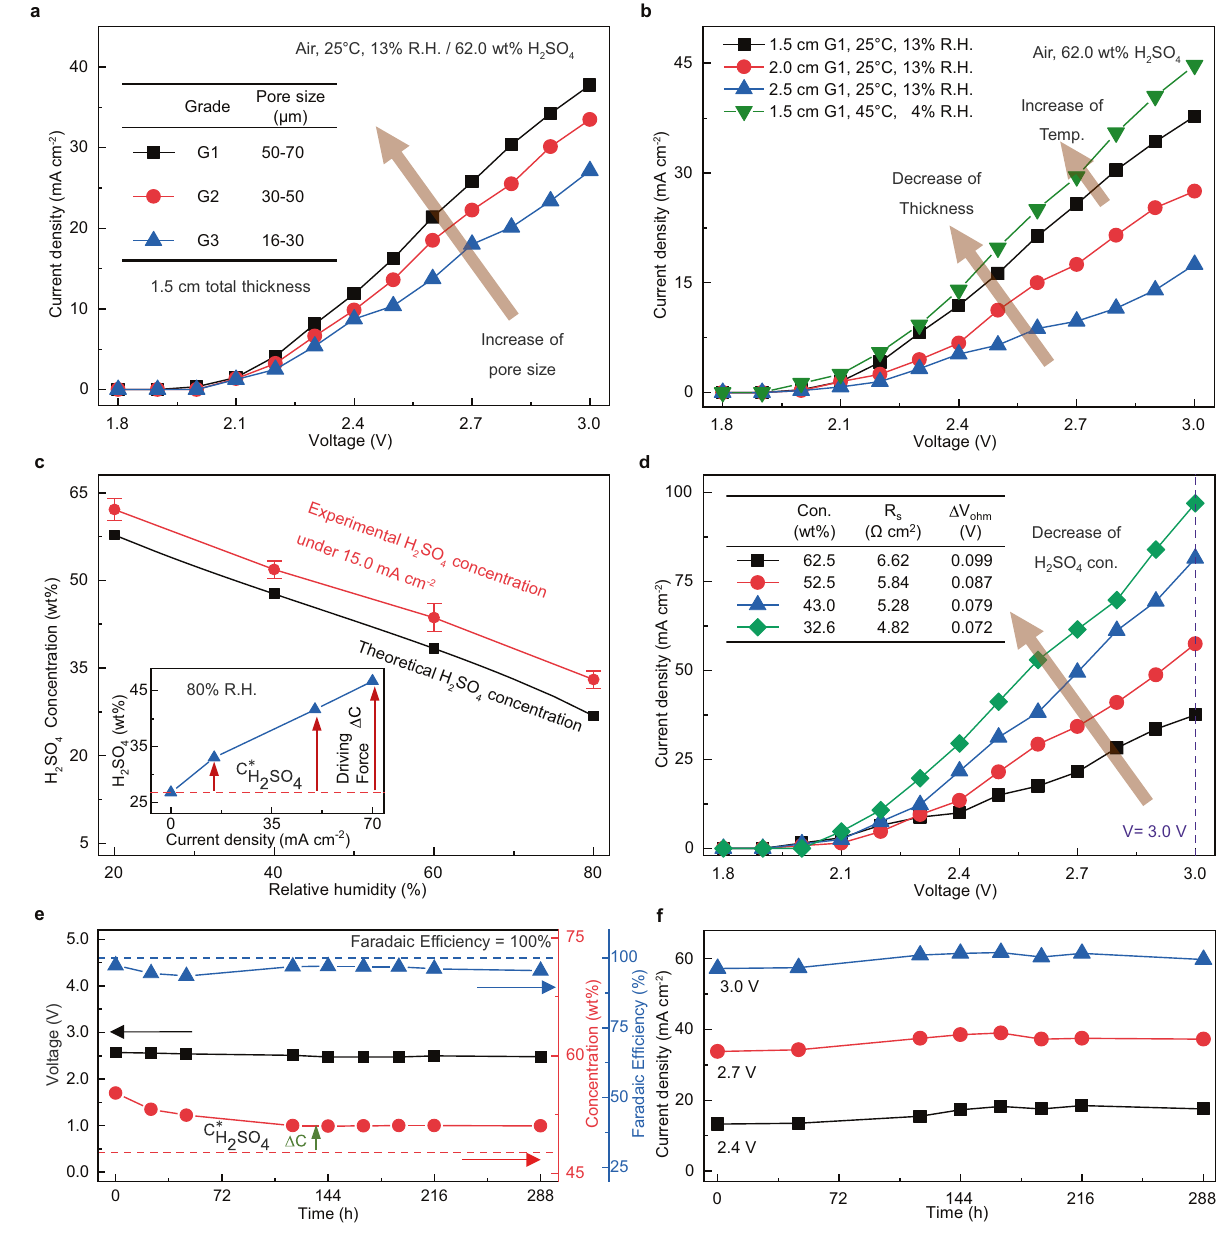
Fig. 3 | DAE module performance at 25°C unless speci fi ed. a J – V curves for dashed line). d The effect of electrolyte concentration on J – V performance. e Example recording of cell voltage (black symbol), H 2 SO 4 concentration (red modules using various porous substrate with different pore sizes. b Effect of =47.7wt% (red dashed line), Faradaic ef fi ciency (blue symbol) for symbol),C * H temperature and foam thickness on J-V performance. c The experimental steady 2 SO 4 DAE modules at constant current density of 15.0mAcm − 2 for 288h at 40% R.H. state concentration of sulfuric acid at J=15.0mAcm − 2 (red) VS equilibrium con- f Currentdensity collected underdifferentvoltagefor288hat 40%R.H.Figures3c (black) under different R.H. Error bars represent standard centration C * H 2 SO 4 deviation, n = 3 independent replicates. The inset shows the effect of current to 3f were operated with G1 sintered glass foam and 1.5cm gap between the two densityonsteadystateconcentrationunder80%R.H.whereC * H electrodes. Source data are provided as a Source Data fi =26.8wt%(red 2 SO 4